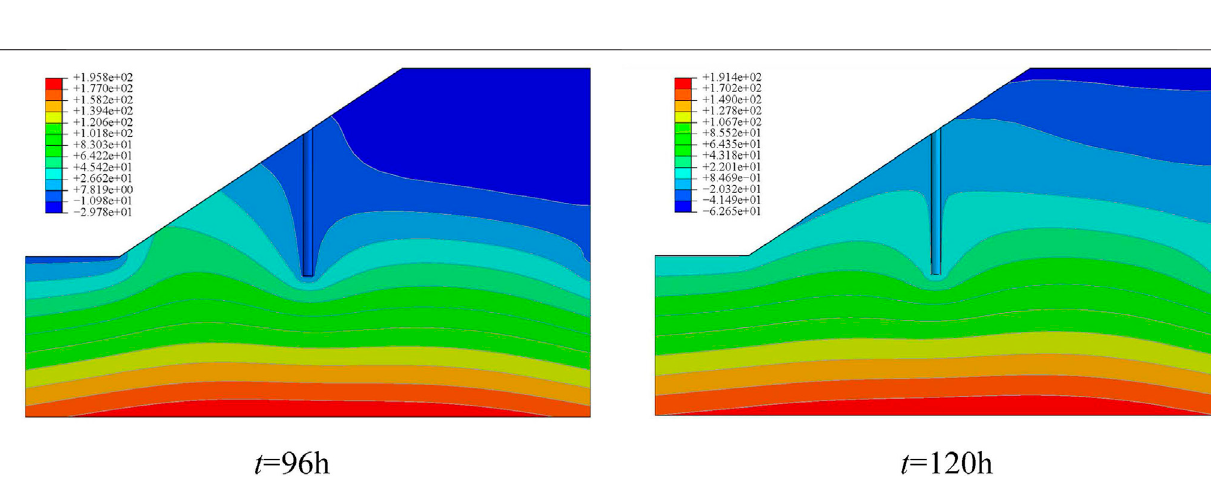
Frontiers in Earth Science |